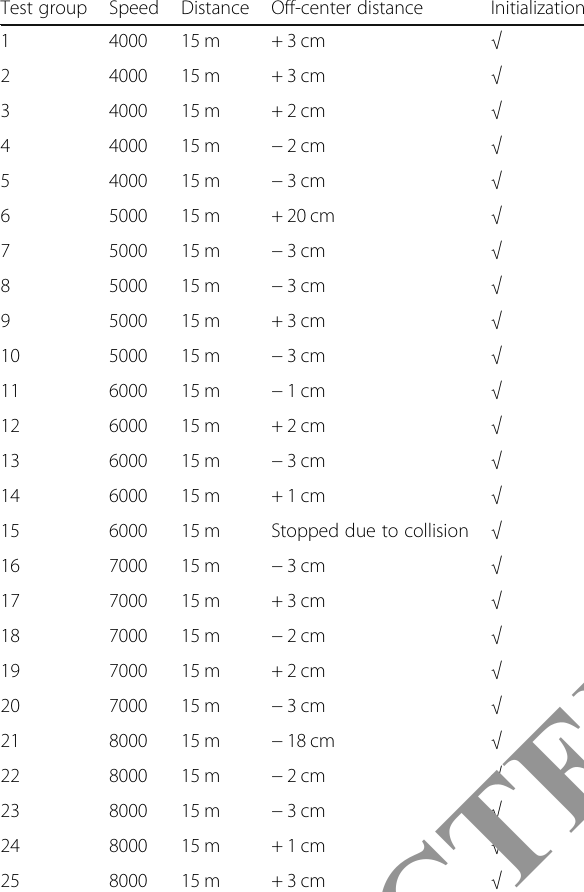
Table 1 Partial experimental data Test group Speed Distance Off-center distance